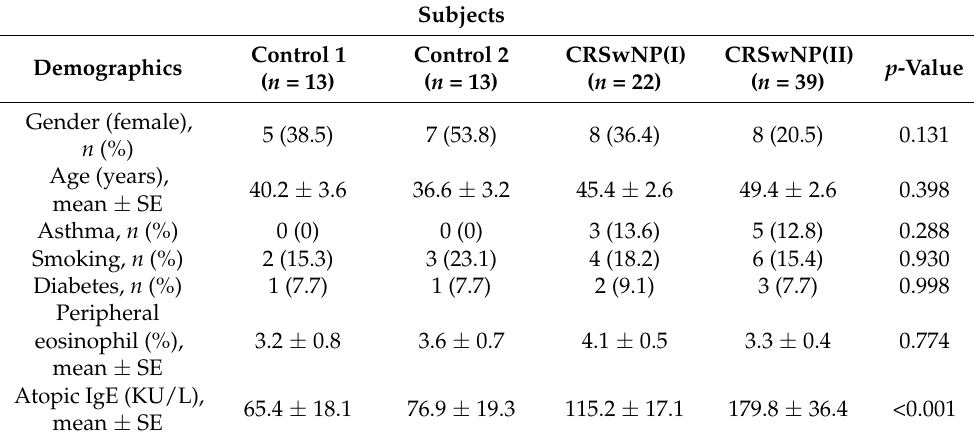
Table 1. Demographics of patients with control groups and CRSwNP